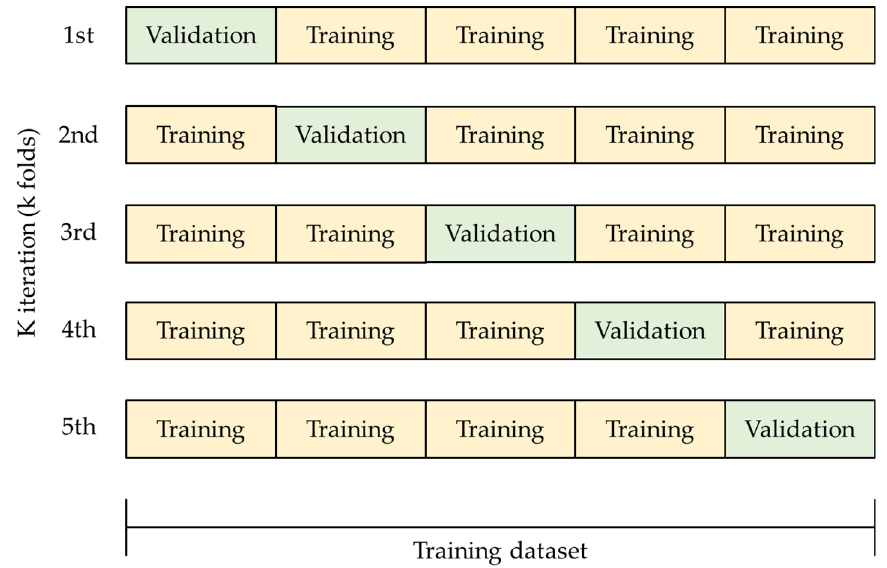
Figure 4. k-fold cross validation procedure: example with 5